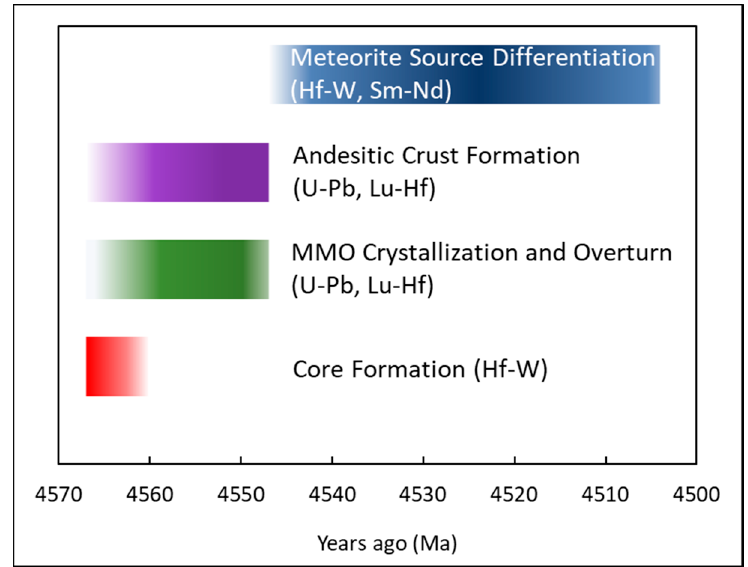
Figure 5. Summary of early Martian events based on various chronometers [16,22,87,89,94,99,100].